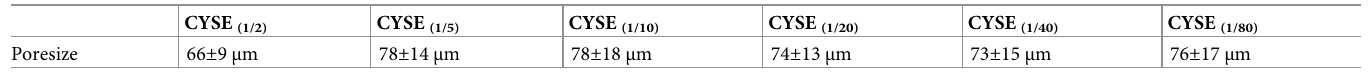
Table 2. Arithmetic mean ± standard deviation of pore size of dried hydrogels determined from SEM microscopic images. CYSE